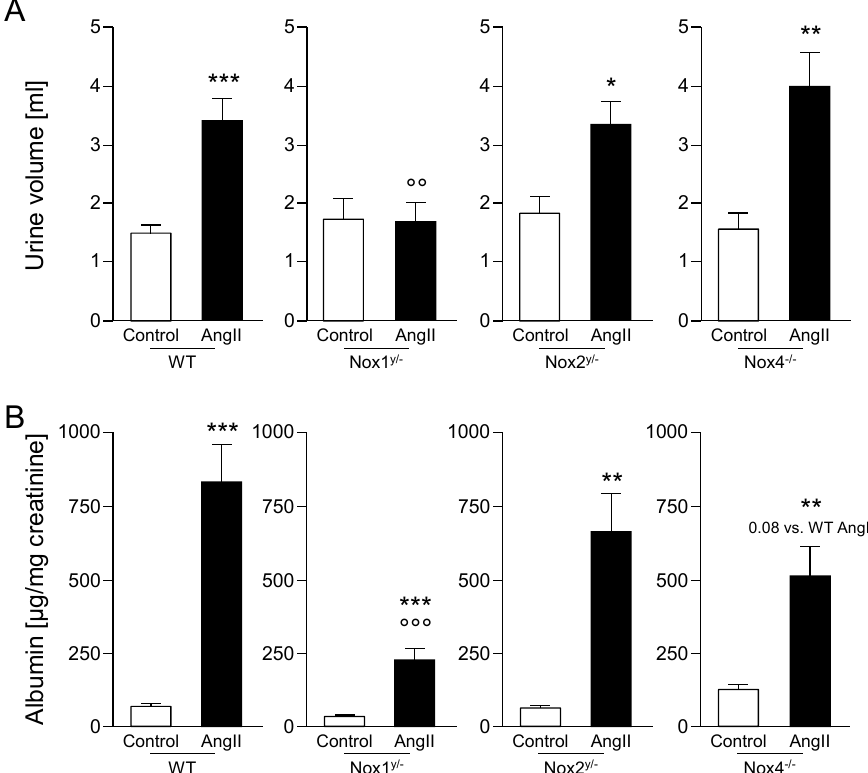
Figure 3. Angiotensin II led to polyuria and albuminuria, which were less pronounced in Nox1 knockout mice. ( A ) Urinary volume; ( B ) Albumin excreted related to creatinine in urine. Data are shown as mean + SEM. * p ≤ 0.05, ** p < 0.01, *** p < 0.001, vs. the respective control animals analyzed by the Student’s t -test; ◦◦ p < 0.01 (F(1.48) = 4.60), ◦◦◦ p < 0.001 (F(1.49) = 10.37) vs. angiotensin II-treated WT animals, analyzed by two-way ANOVA. WT, wildtype; AngII, angiotensin II; Nox, NADPH oxidase catalytic subunit.